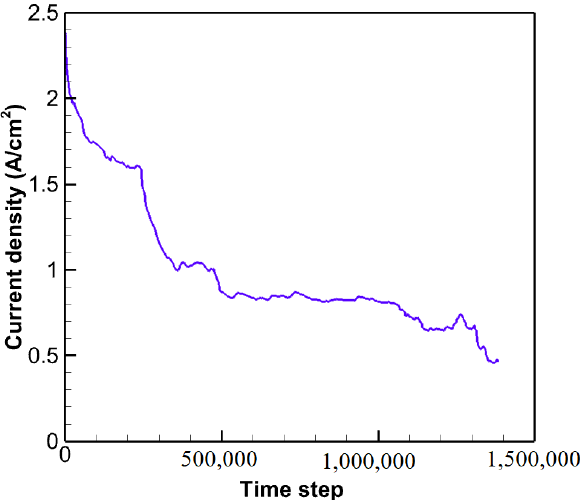
Figure 6. Time evolution of the current density.